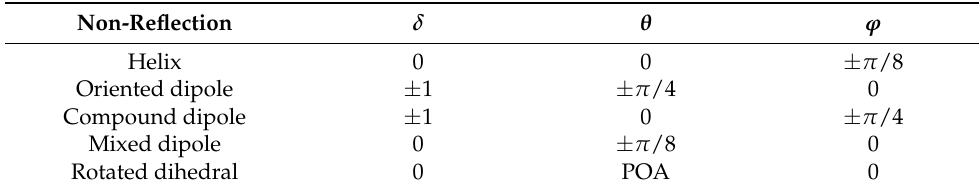
Table 2. Connections between orthogonal scattering models and non-reflection symmetry scatter- ing